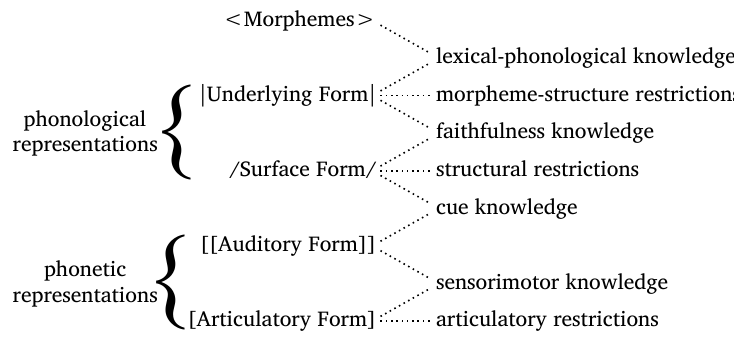
Figure 1: Levels of representation and stored